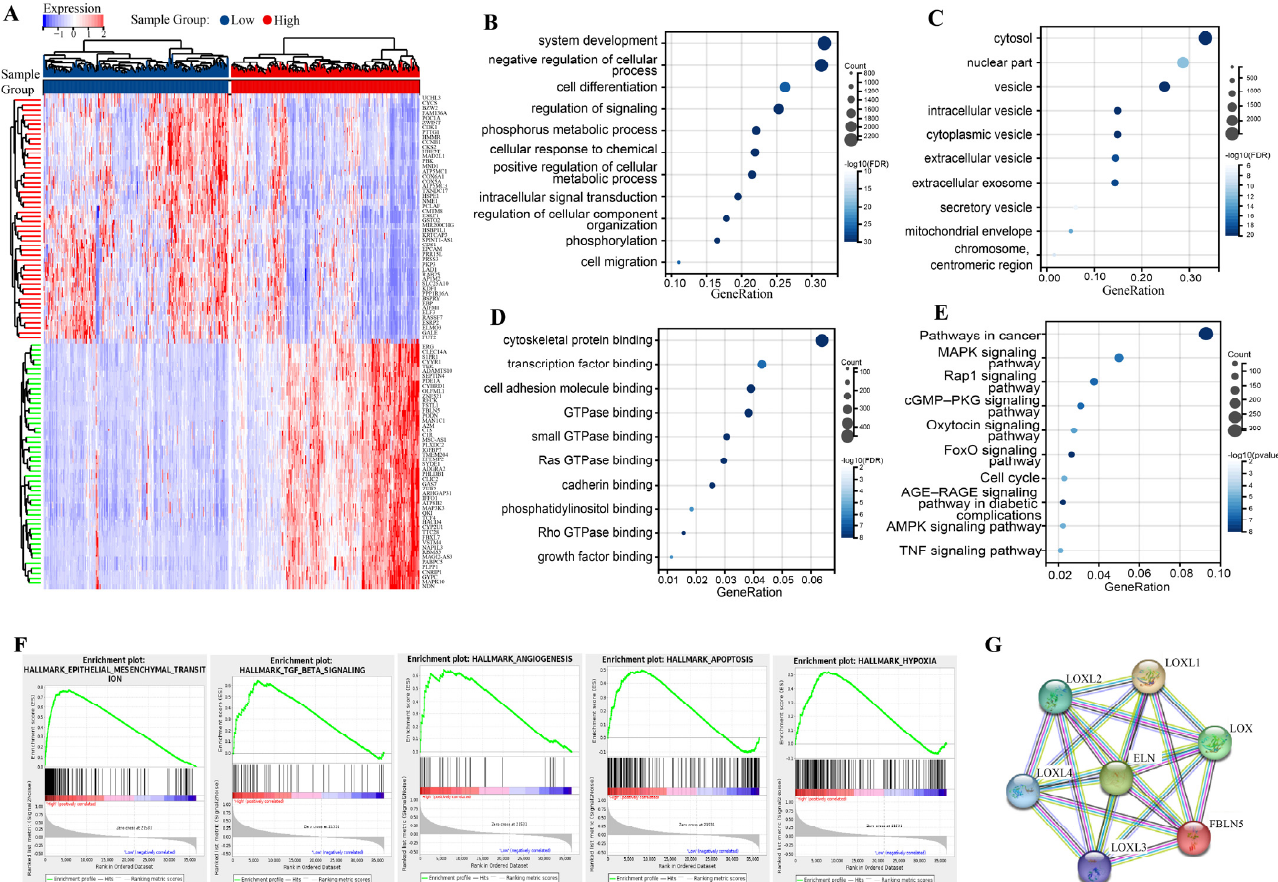
Figure 2. Analyses of biological functions of FBLN5. ( A ) Analysis of the differential genes between groups expressing high and low levels of FBLN5 using the limma package. Representative GO enrichment analysis between groups expressing high and low levels of FBLN5 based on TCGA-GC data, which included the following: ( B ) Biological processes (BP) associated with FBLN5 gene functions, ( C ) Cellular components (CC) of FBLN5 gene functions, ( D ) Molecular functions (MF) associated with FBLN5 gene functions. ( E ) Representative KEGG enrichment analysis between groups expressing high and low levels of FBLN5 based on TCGA-GC data. ( F ) GSEA analysis of the group expressing high levels of FBLN5 using hypoxia, angiogenesis, TGF- β , EMT, and apoptosis signals (ALL|normalized enrichment score (NES)| > 1, nominal (NOM) p -value < 0.05 and FDR q -value < 0.25). ( G ) PPI analysis of FBLN5-associated proteins.